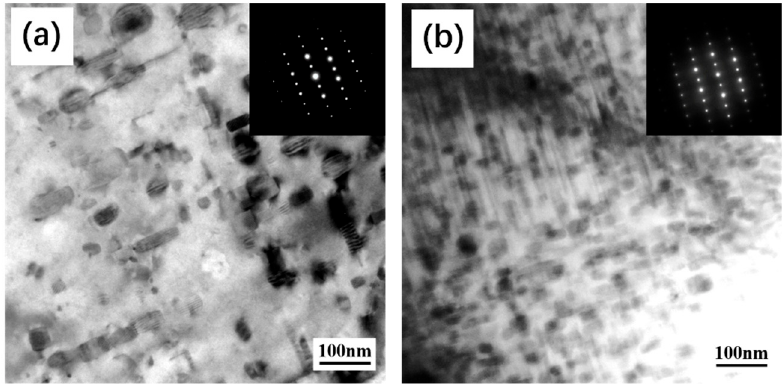
− − 20 ] zone axix: ( a ) single zone axix: ( a ) single